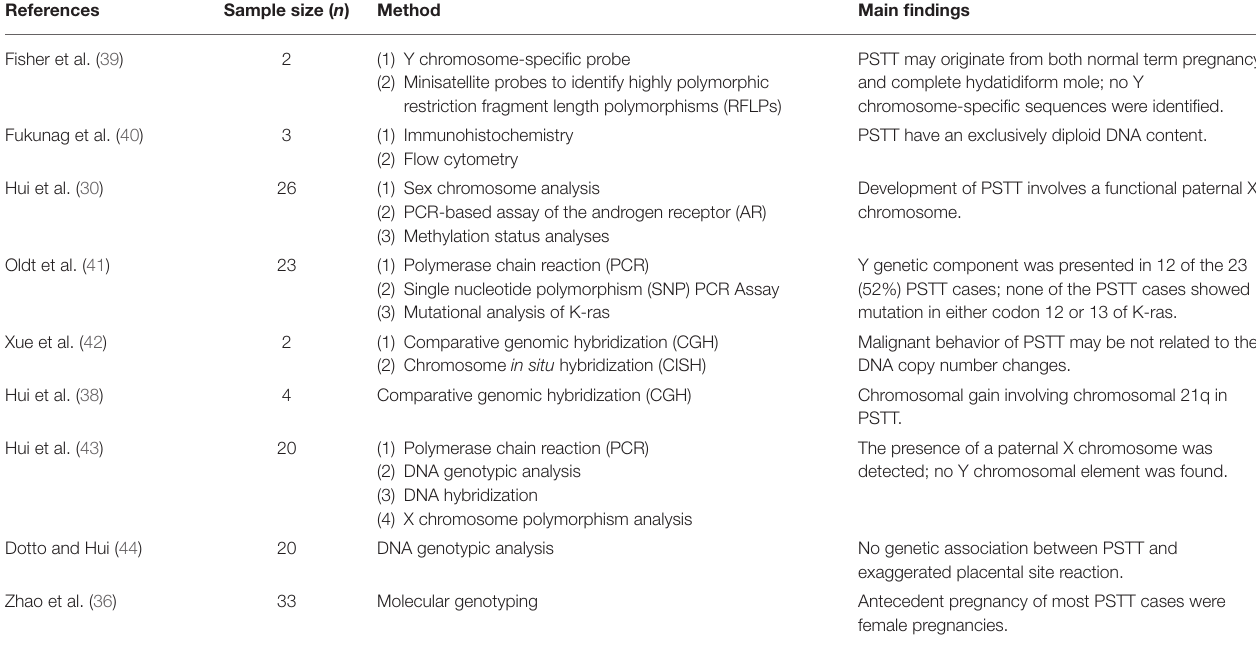
TABLE 1 | Major findings from genetics studies of PSTT.